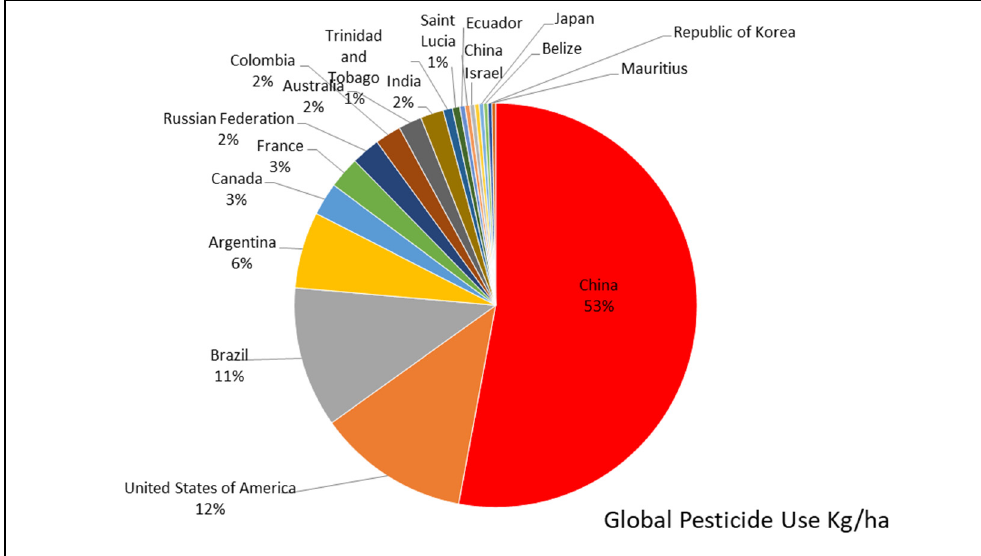
Figure 1. Global pesticide use (kg/ha) (data were taken from FAO-STAT 2022).